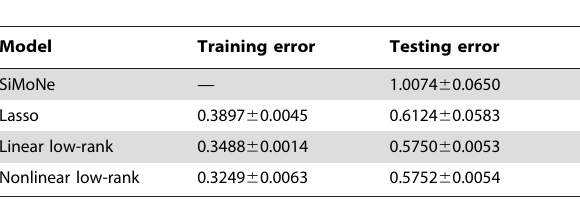
Table 1. Root-mean-squared error (RMSE) comparison among different models on the yeast gene expression